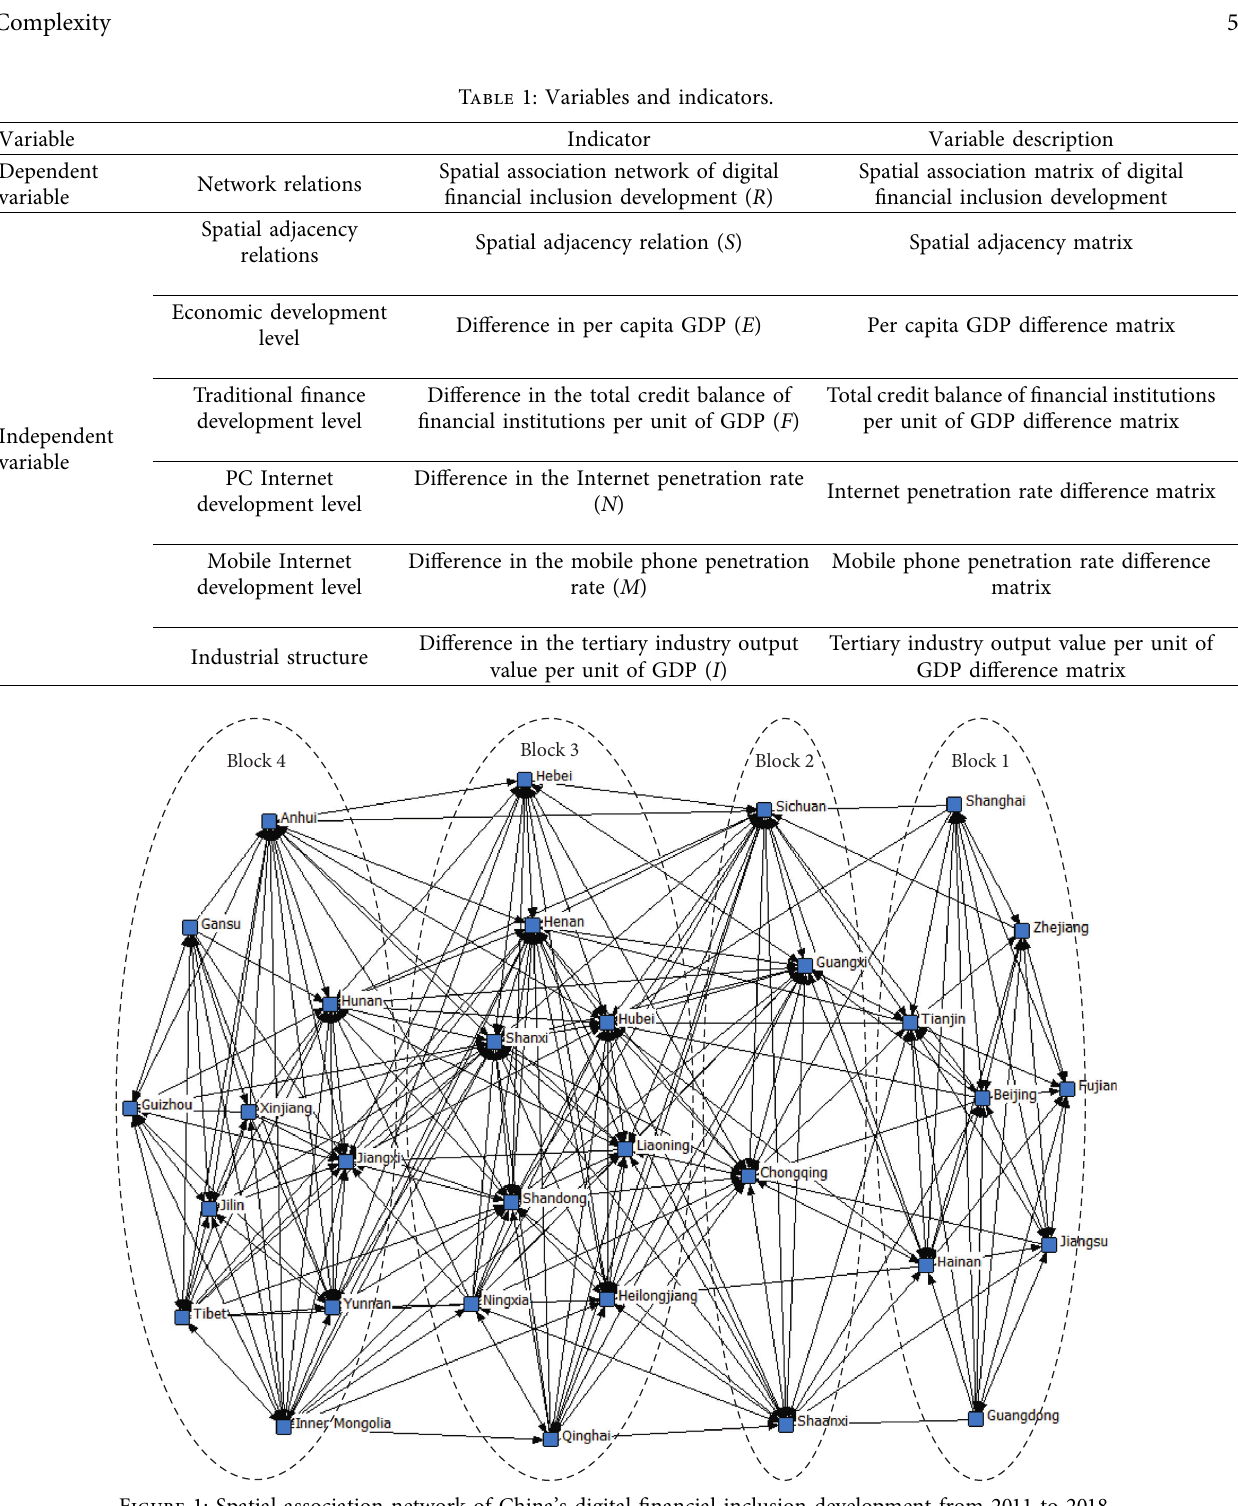
Figure 1: Spatial association network of China’s digital financial inclusion development from 2011 to